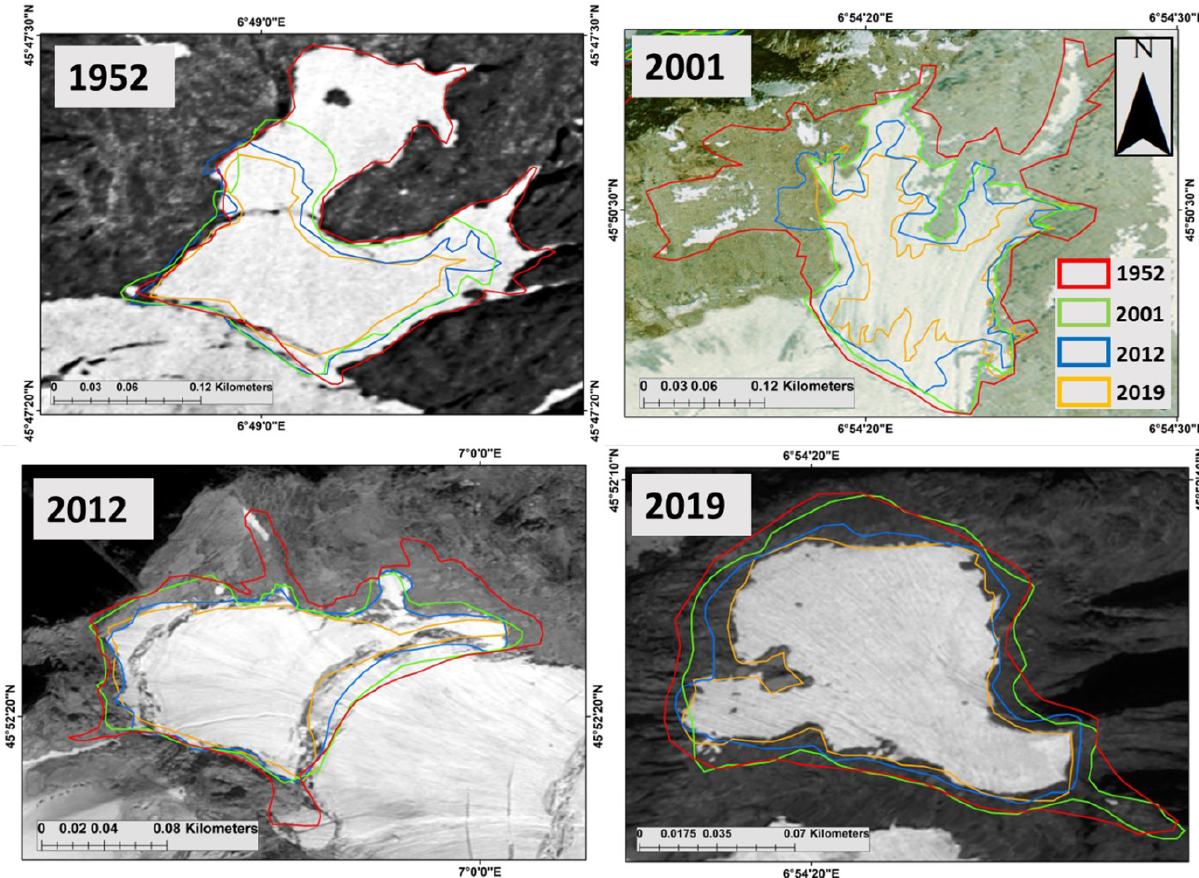
Figure 6. IA extent delineated on high-resolution images: (a) orthophotos 1952, (b) orthophotos 2001, (c) Pleiades panchromatic 2012 and (d) Pleiades panchromatic 2019. The different coloured polygons represent the surface area for each date. The orthophotos are courtesy of the IGN, while the Pleiades images were acquired as part of the CNES Kalideos Alps